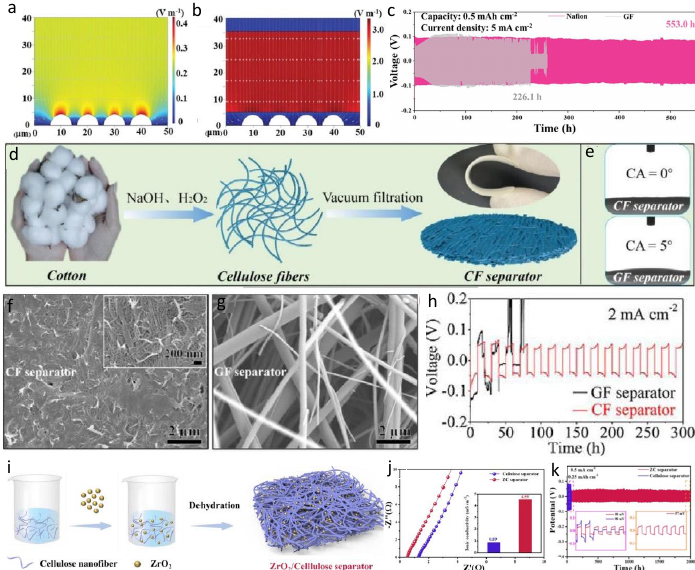
Figure 19. Distribution of electric fields within ( a ) GF separator and ( b ) Zn-Nafion separator, and ( c ) cycle life of the Zn symmetric cell with Nafion and GF separator. (Reproduced with permission. [214] Copyright 2021, Royal Society of Chemistry). ( d ) Diagram illustrating the preparation of CF separators, ( e ) comparison of contact angles between CF and GF separator, SEM images of ( f ) CF separator and ( g ) GF separator, and ( h ) cycling performance at 2 mA cm − 2 –20 mAh cm − 2 of Zn symmetric cells with CF and GF separators. (Reproduced with permission [216] Copyright 2022, Elsevier). ( i ) Schematic illustration of fabricating CZ separators, ( j ) ionic conductivity of cellulose and CZ separator, and ( k ) voltage–time profiles of Zn symmetrical cells with CZ and cellulose separators. (Reproduced with permission [217] Copyright 2021, Elsevier).